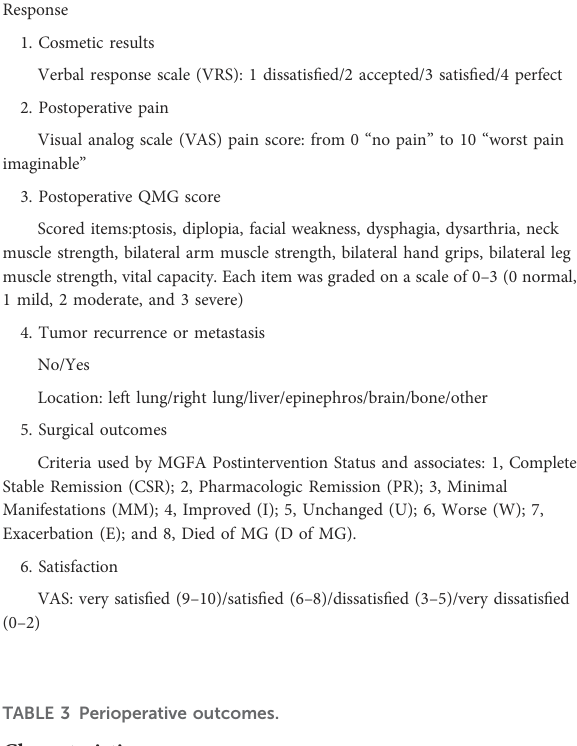
TABLE 2 Follow-up questionnaire. Nature of question Response